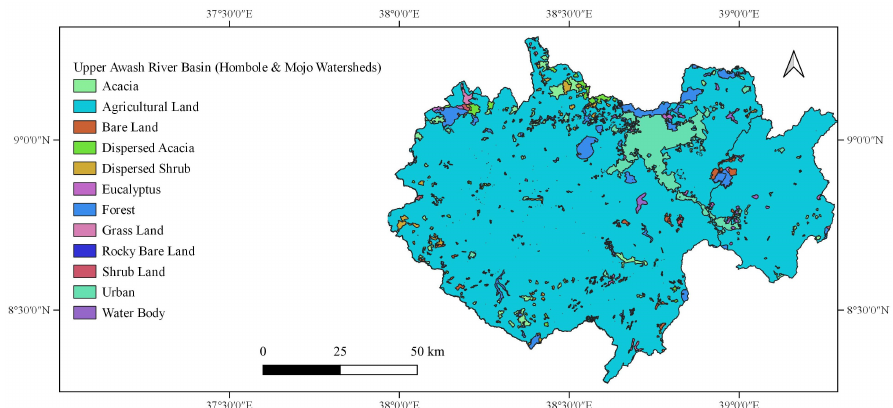
Figure A6. Land use map of Upper Awash River Basin (Hombole and Mojo watersheds) from 2009 to 2012.